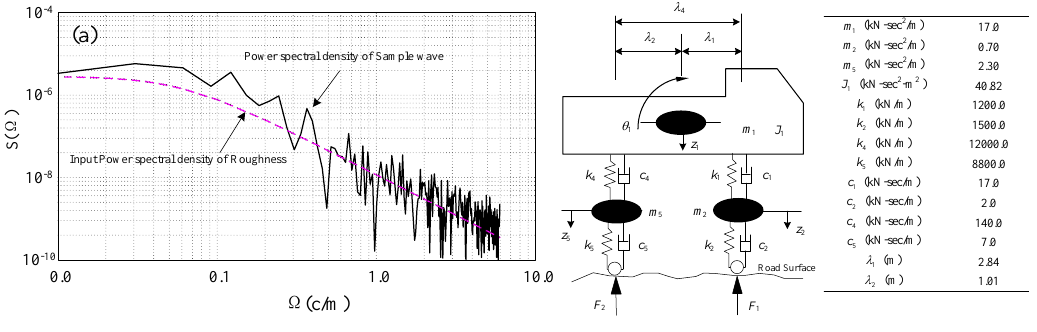
Figure 20. ( a ) Four-degree vehicle model; ( b ) power spectral density of sample wave.